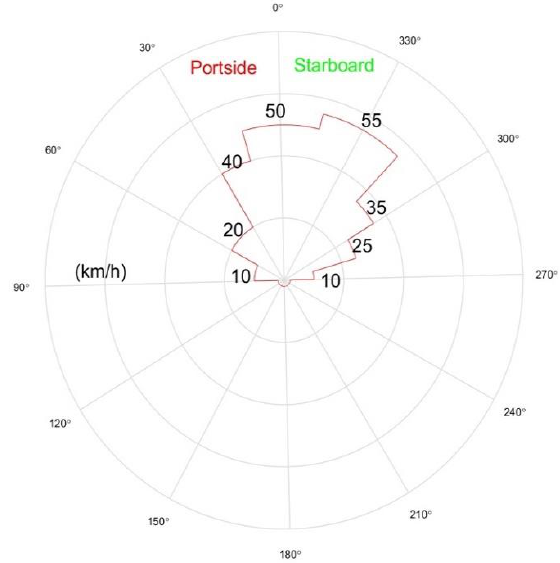
Figure 21. Calculated candidate SHOL envelope of LPD17 with SA365